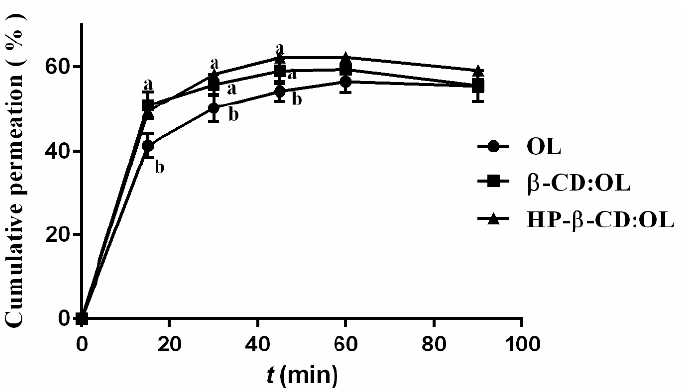
Figure 6. The Permeation curves of OL and its inclusion complexes across mouse small intestine. Different letters represent significant differences ( p < 0.05).